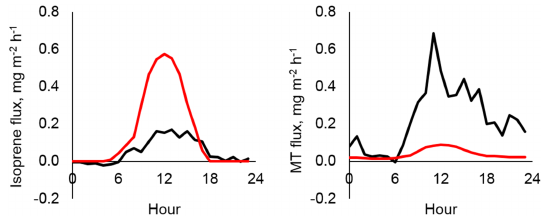
Figure 6. Diurnal cycles of isoprene (left) and monoterpene (MT, right) emission fluxes from 3 days of eddy covariance measure- ments at Tumbarumba during November 2006 (black). Modelled emission fluxes are plotted from the same time period (red). Table 2. Average (min–max) observed isoprene and monoterpene concentrations at all four field sites.